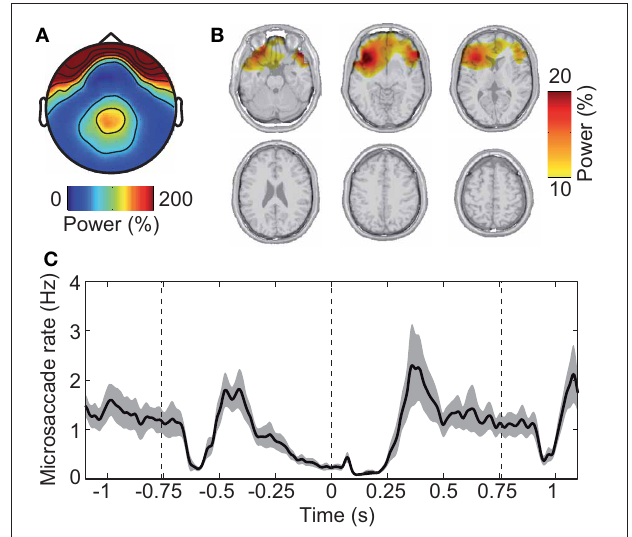
FIGURE 4 | Effect of ICA-cleaning of cranial muscle artifacts. Same sensor-level and source-level analysis of stimulus induced responses as displayed in Figure 2 . (A) Left: power response relative to prestimulus baseline resolved in time and frequency for occipito-parietal electrodes of interest (see inset for electrode positions). Statistically significant differences are indicated by saturated colors ( t -test, p < 0 . 05), and by contour lines ( t -test, p < 0 . 05, Bonferroni corrected for time and frequency). Right: scalp topography of power responses in the time-frequency range indicated by the dashed box in the left panel. (B) Left: power response relative to prestimulus baseline resolved in time and frequency for an occipito-parietal source region of interest (see inset for region of interest; CS: central sulcus). Right: spatial power distribution in the time-frequency range − 0.65 to 0.05s and 50–110Hz.